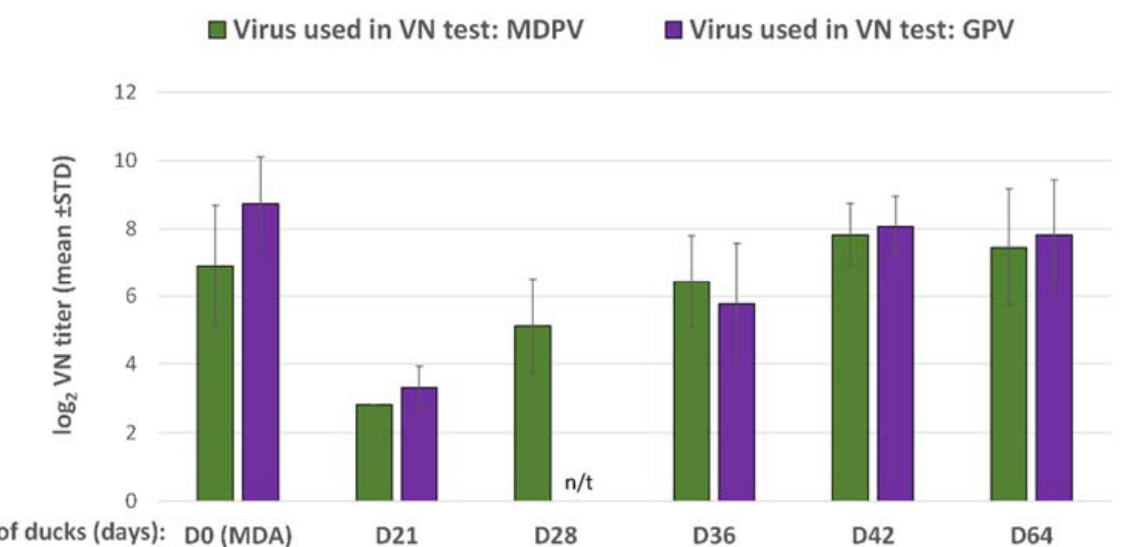
Figure 7. Humoral antibody response in MDA ‐ positive ducks, vaccinated with the bivalent vaccine in a prime–boost regime. (n/t = not tested)